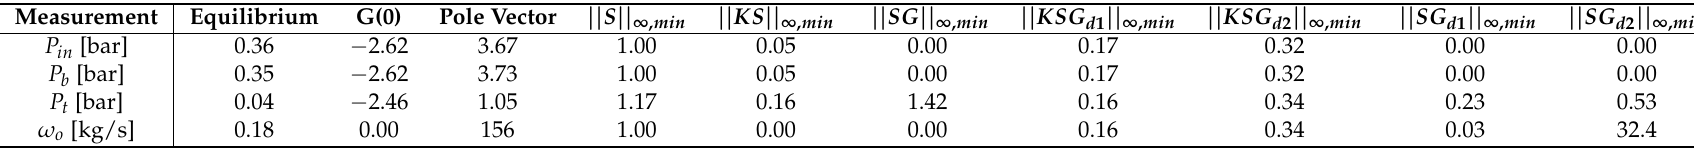
Table 3. Model analysis for Z = 30%.